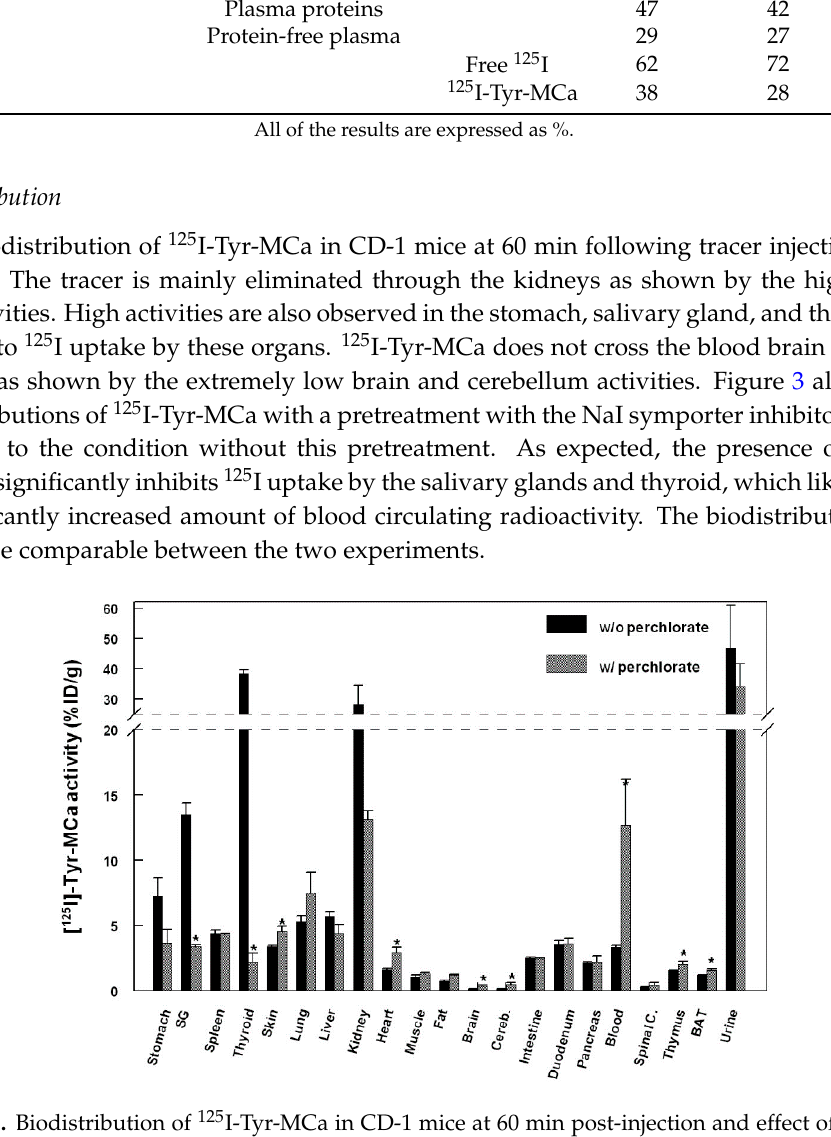
Table 2. In vivo blood distribution pattern and stability analysis of 125 I-Tyr-MCa in protein-free plasma at 15 and 30 min following potassium perchlorate pretreatment and intravenous injection to mice. Blood Distribution 15 min 30 min 125 I-Tyr-MCa Blood cells